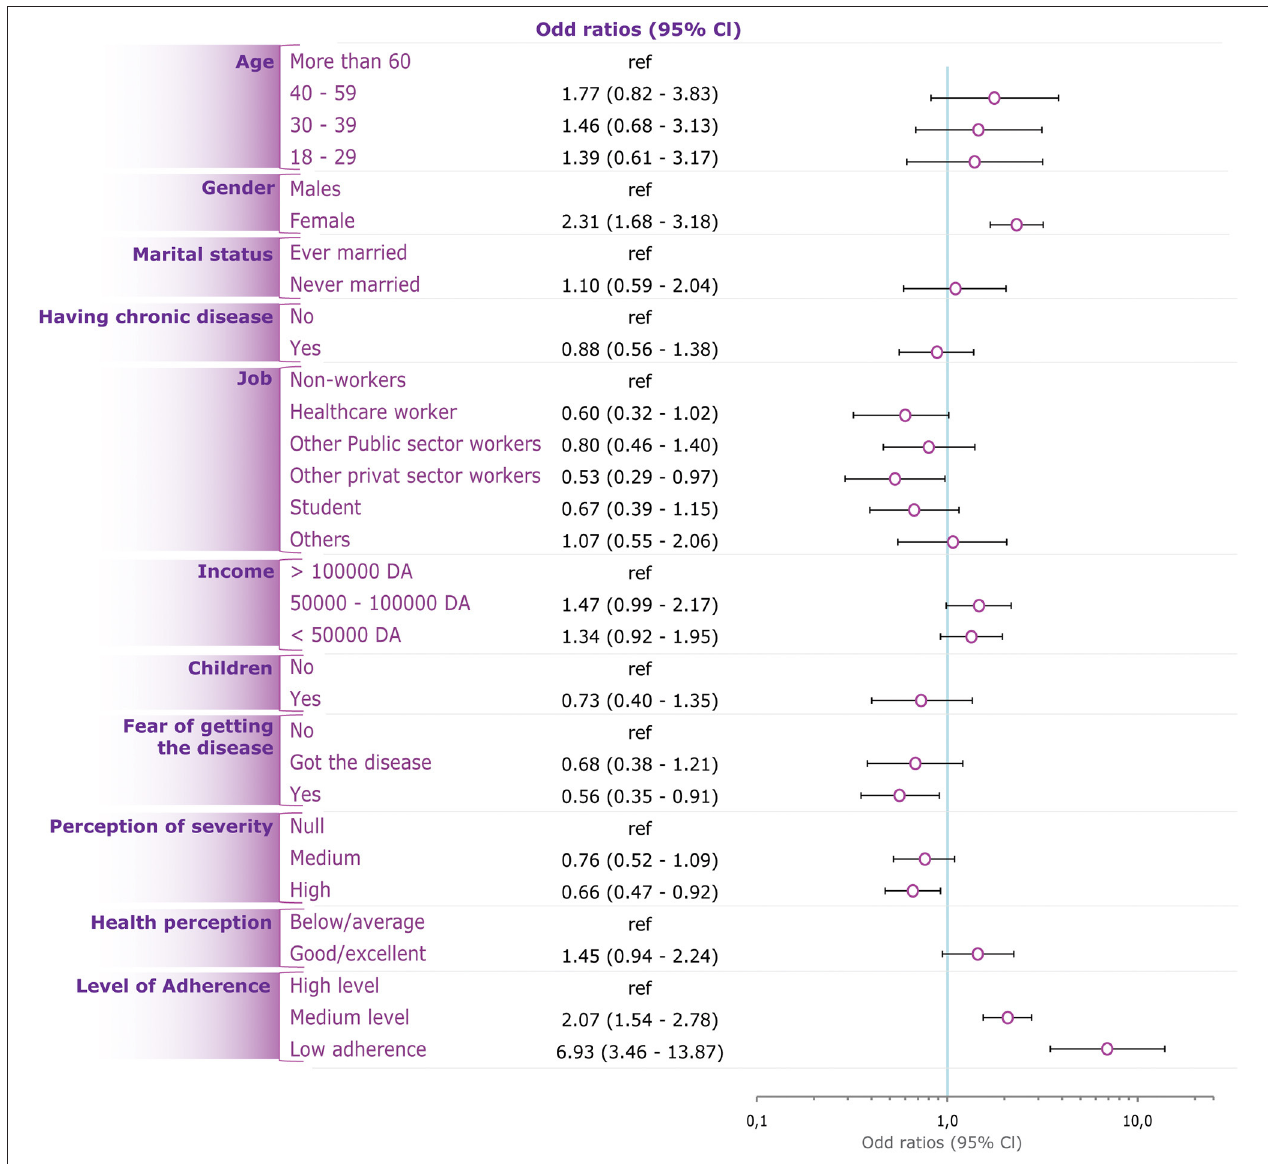
FIGURE 3 | Predictors of nonengagement to COVID-19 vaccine in